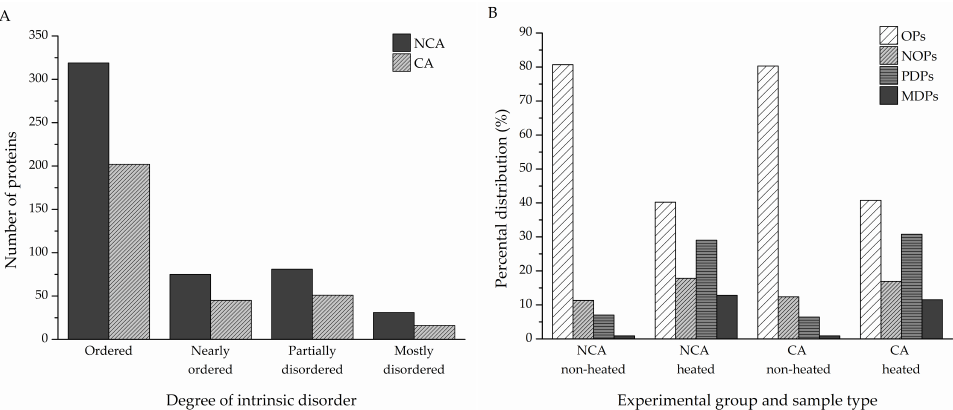
Figure 3. ( A ) Total number of proteins with varying degrees of intrinsic disorder—ordered (OPs, 10% at most), nearly ordered (NOPs, 10–30%), partially disordered (PDPs, 30–70%), mostly disordered (MDPs, at least 70%). ( B ) Effect of heat treatment on the percental distribution of proteins with varying degrees of intrinsic disorder in the two sample types of both experimental groups. NCA— non-cold-acclimated diapausing group; CA—cold-acclimated diapausing